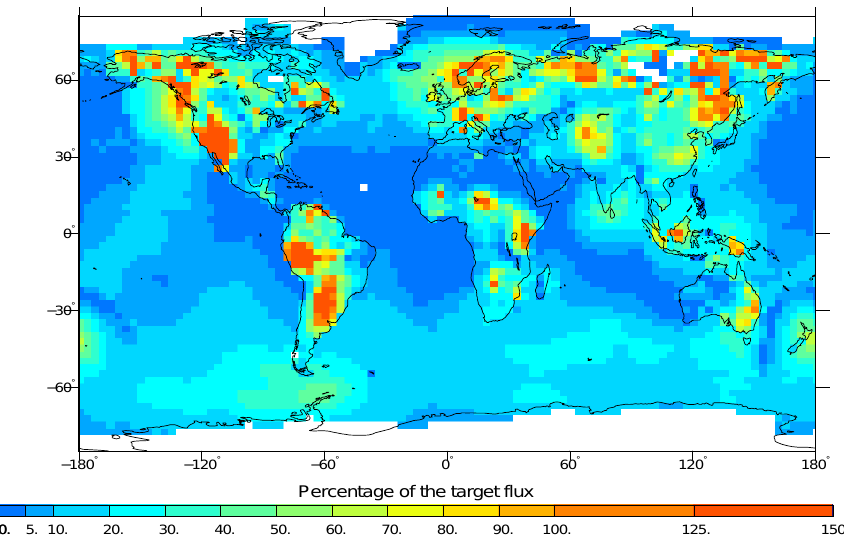
Fig. 13. Map of the spread of methane inverse estimates at the model grid-scale as a percentage (%) of the target flux (INV emission scenario).